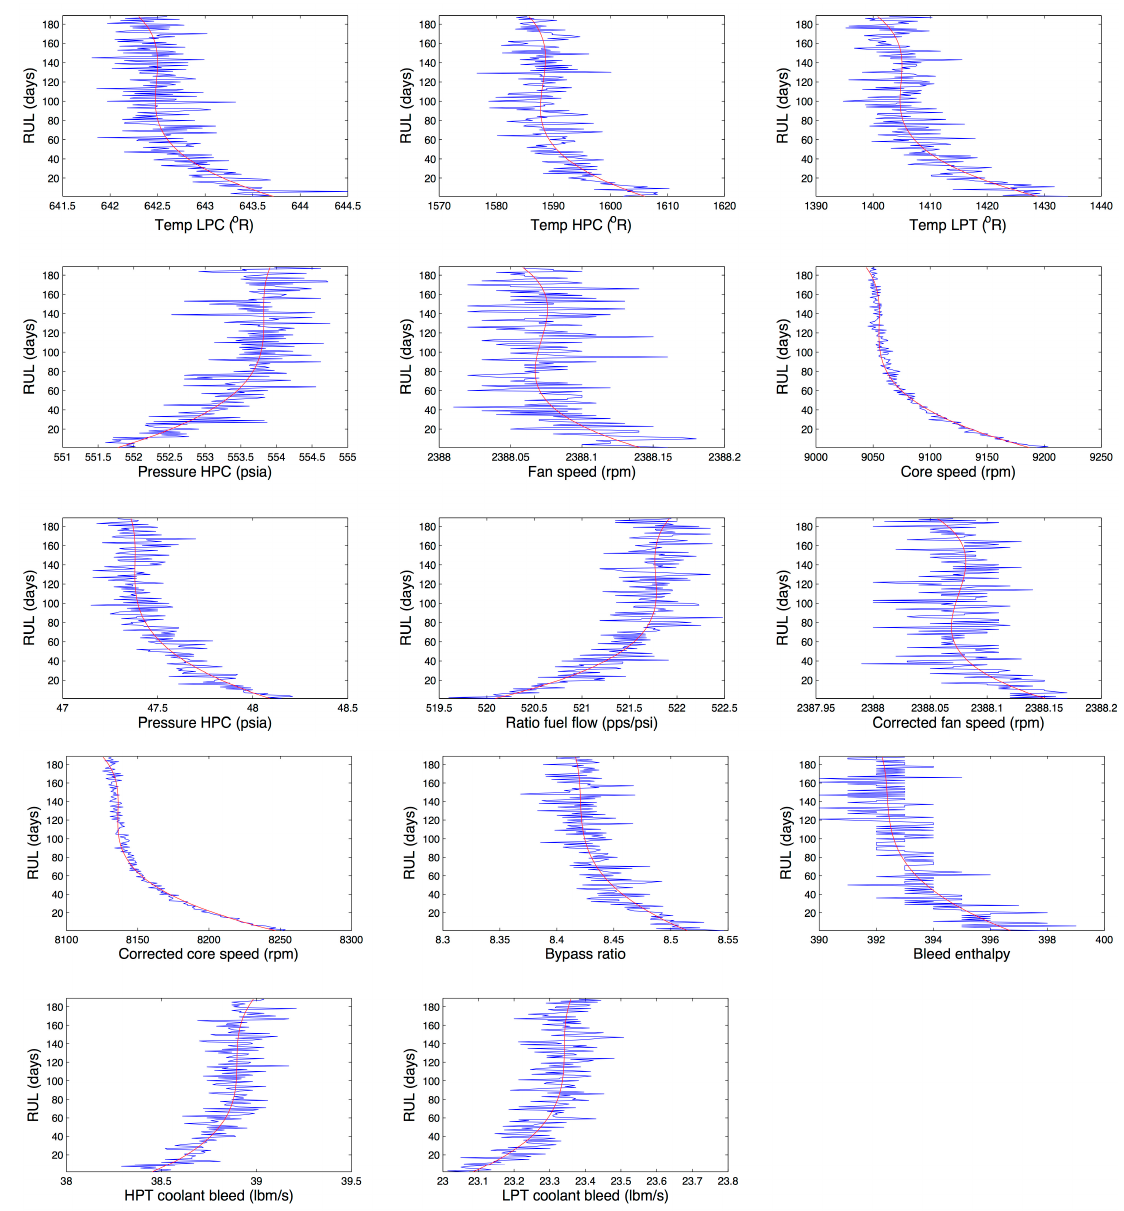
Figure 3. Correlation matrix of this problem with the two discarded independent variables: Physical core speed (C_sp) and Corrected core speed (C_csp).